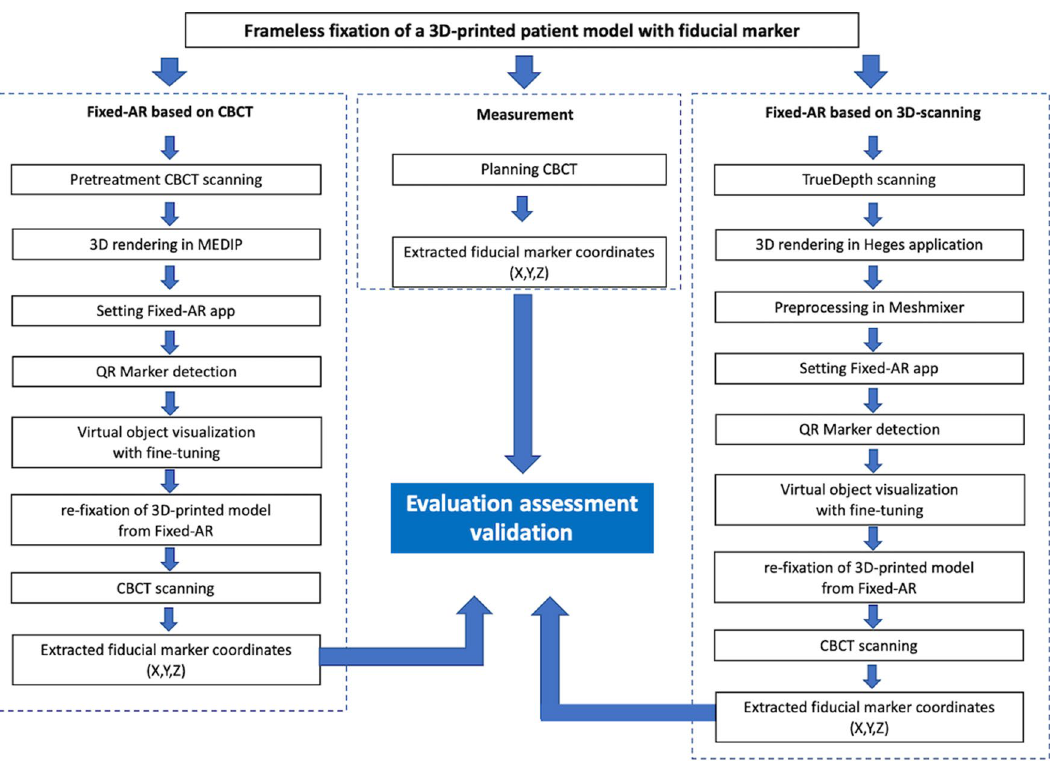
Figure 3. Schematic illustration of the procedure to evaluate frameless fixation for